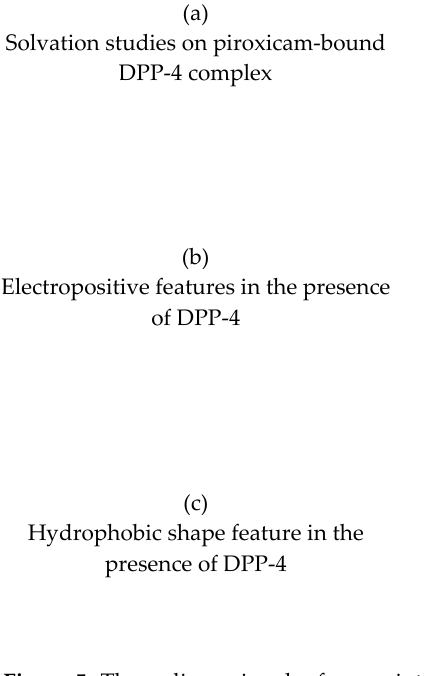
Figure 5. Three-dimensional reference interaction site model (3D-RISM) analysis to understand the stability of water molecules at the piroxicam-bound DPP-4 proteins ( a ) The 3D-RISM run analysis reveals oxygen isodensity surface at ρ = 5 and localized 3D-RISM waters, colored by ∆ G. ( b ) Electropositive surface features (red) of the NSAID drug piroxicam in the presence of DPP-4 and bulky water. ( c ) Hydrophobic shape features (brown or gold) of the NSAID drug piroxicam in the presence of DPP-4 and bulky water.